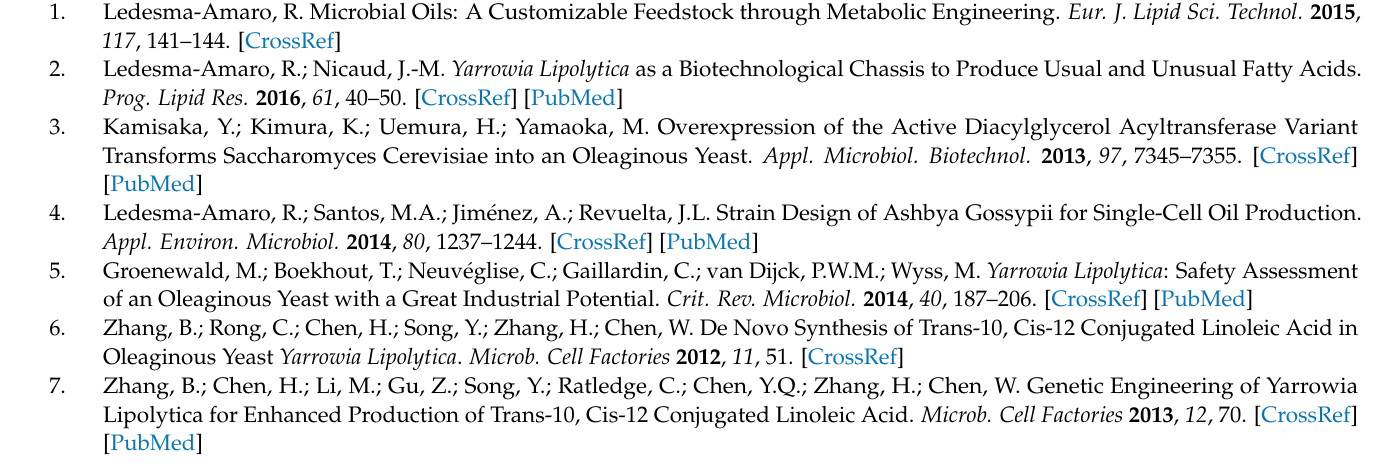
Figure S2: GCxGC-MS chromatogram of yeast sample 7084 (co-cultured with C16:2 ∆ 10,12 -Me) with description and location of new fatty acids. (c)—conjugated double bonds, (i)—isolated double bonds, (c,i)—one conjugated and one isolated double bond. Oleic and palmitoleic FAs are highlighted for better orientation in